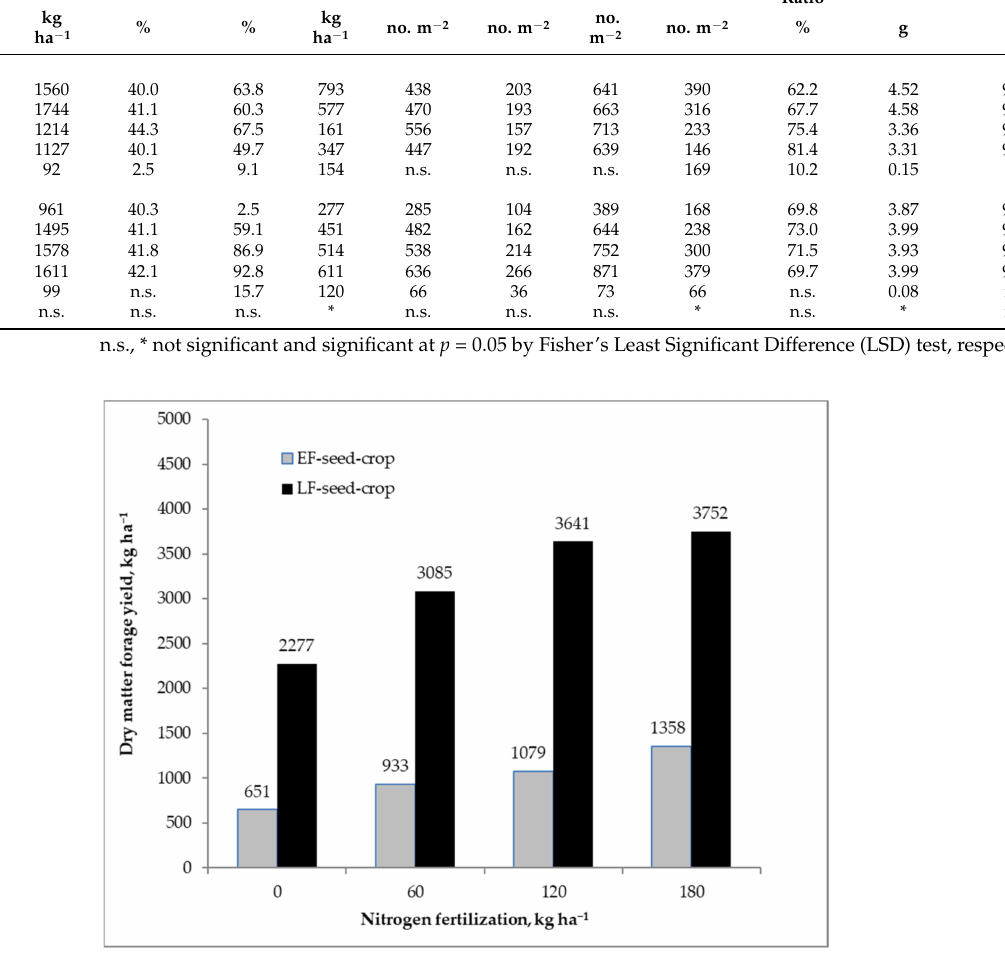
Figure 1. Effect of nitrogen fertilization on forage yield in the dual-purpose crops of Italian ryegrass at early (EF-seed-crop) and late (LF-seed-crop) spring cutting date. LSD (0.05) = 357 kg ha − 1 for comparing means within the same management system, LSD (0.05) = 928 kg ha − 1 for comparing means within the same N fertilization, LSD (0.05) = 913 kg ha − 1 for comparing means across management system and N